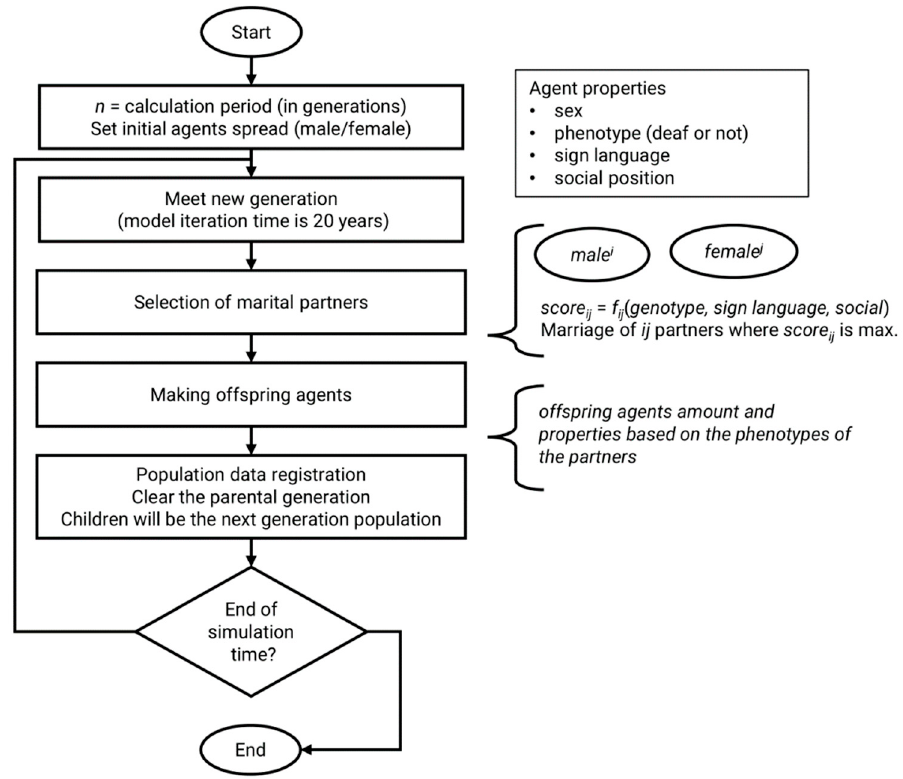
Figure 1. Simplified scheme of the main cycle of the program. At the initial stage, a population of agents (individuals) is created according to the parameters set by the user. The population of the next generation consists of the progeny of the agents of the previous generation.